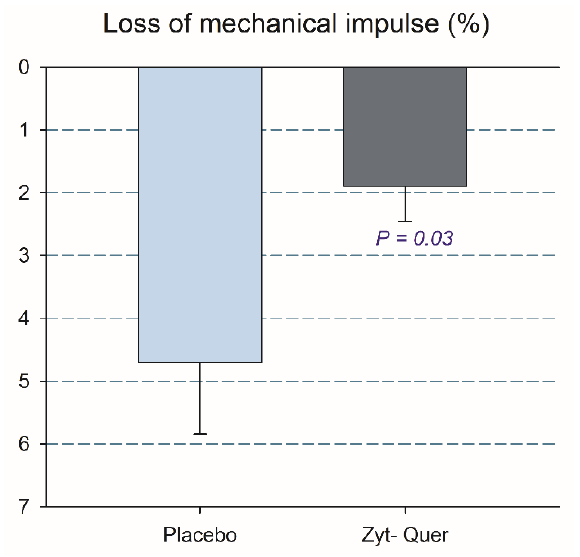
Figure 3. Mechanical impulse lost 24 h after a 10 km race followed by 100 drop jumps. The error bars represent the standard error of the mean. Placebo, N = 23; polyphenols, N = 25.